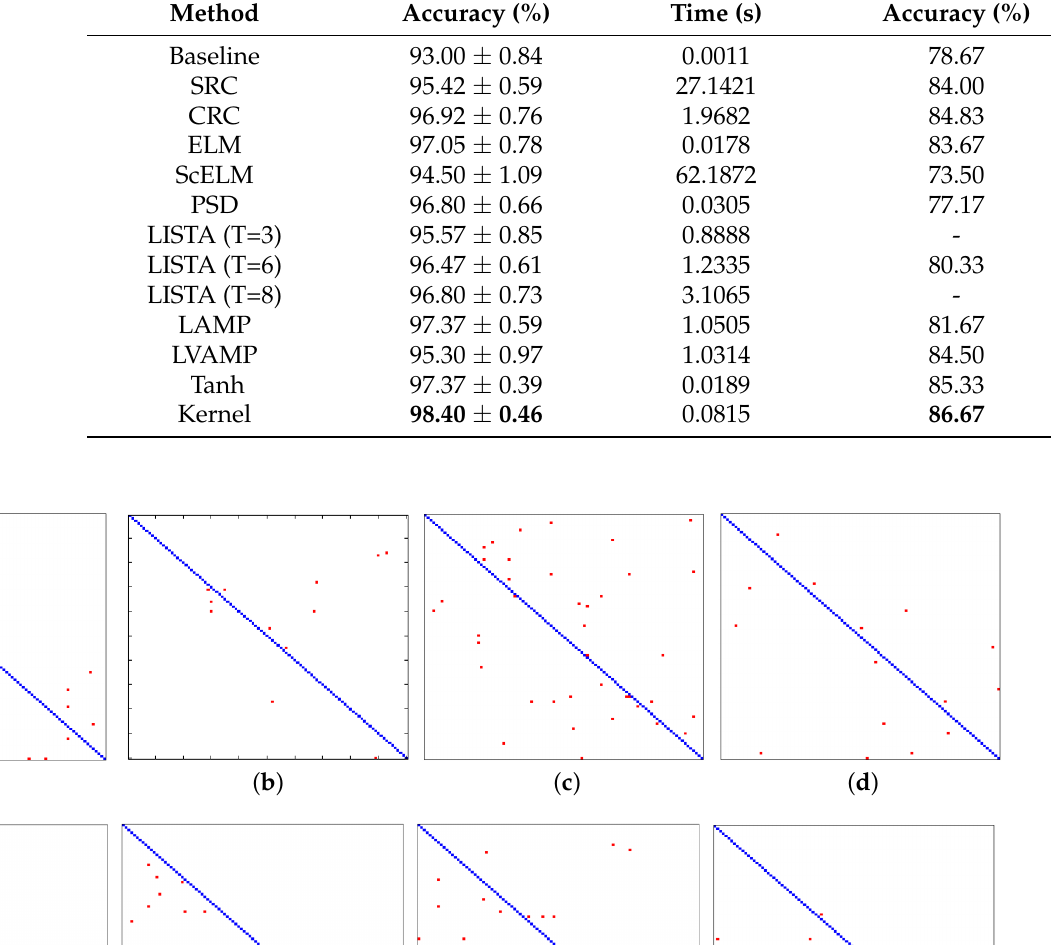
Table 9. Average Recognition Accuracy with Random-Face Features on the AR Face Database. The four column is the result when only 5 training samples per class are used.